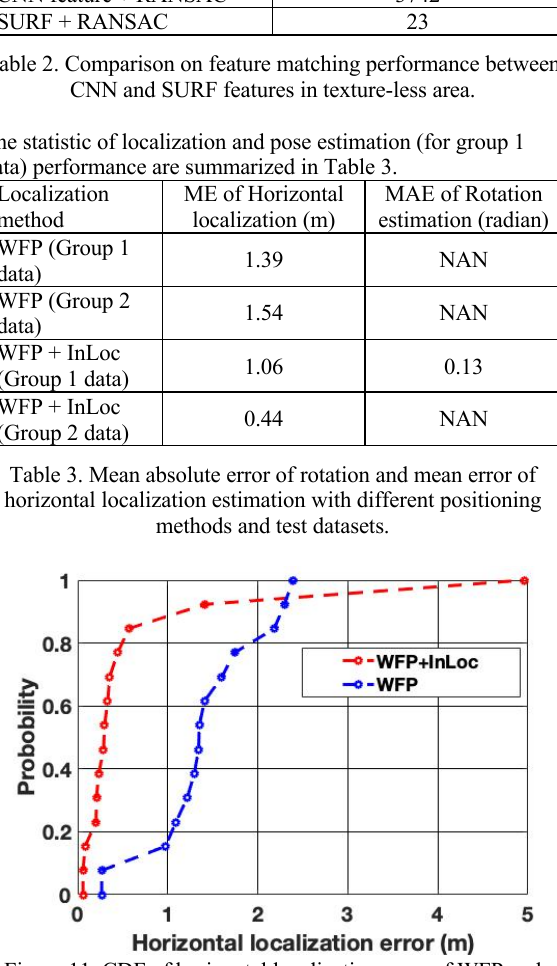
Figure 11. CDF of horizontal localization error of WFP and WFP + InLoc with 13 test datasets.